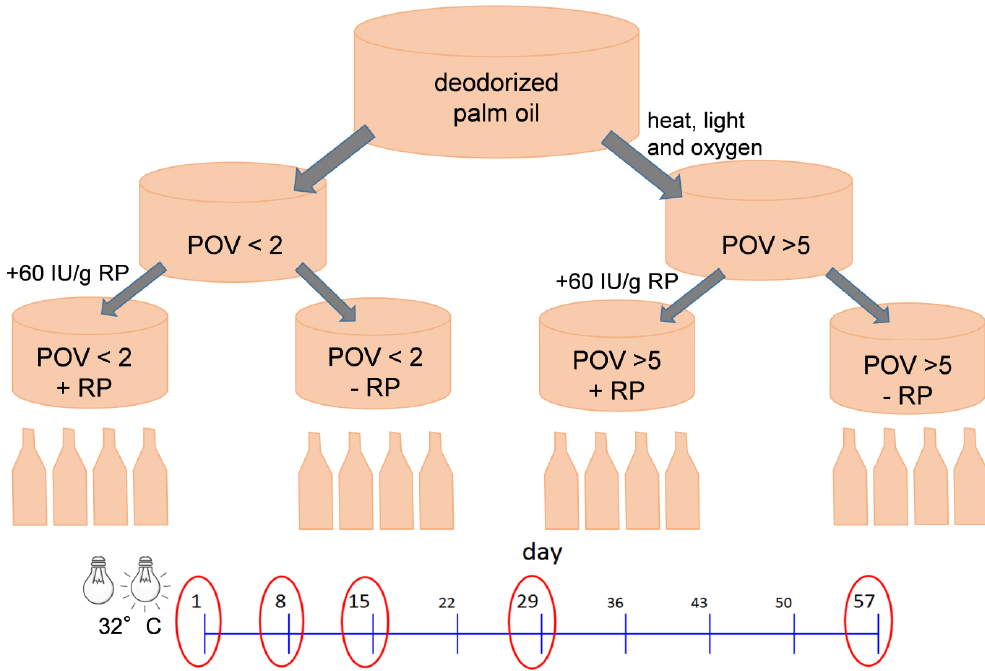
Figure 1. Study design. Four bottles filled with mildly (peroxide value (POV) < 2 meq O 2 /kg) or highly (POV > 5 meq O 2 /kg) oxidized palm oil, either fortified or not with 60 International Units (IU)/kg retinyl palmitate (RP), were stored under household ‐ representative conditions under cold fluorescent light for 12 h per day at 32 °C for 57 days. Samples (40 mL) were withdrawn on a weekly basis, while samples from day 1, 8, 15, 29, and 57 were used for analyses.